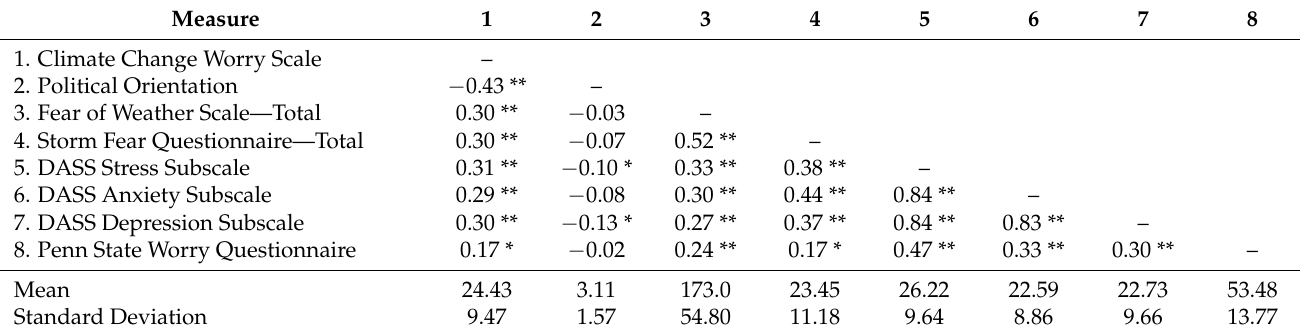
Table 7. Correlation of the Climate Change Worry Scale with political orientation, fear of weather/storms and other negative emotion.